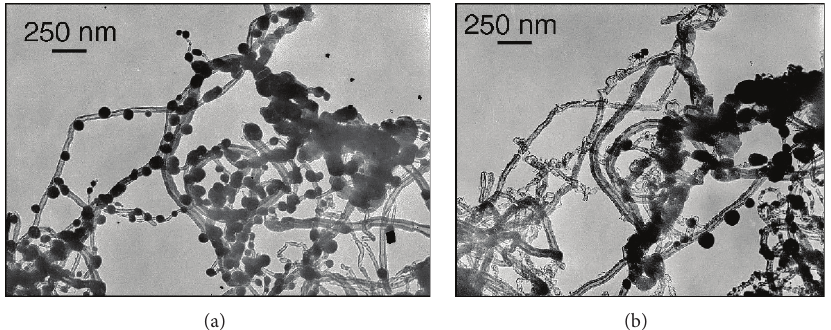
Figure 3: TEM image of unsupported carbon nanotubes with (a) deposited Ni nanoparticles and (b) through holes of nanometer scale on walls of carbon nanotubes.